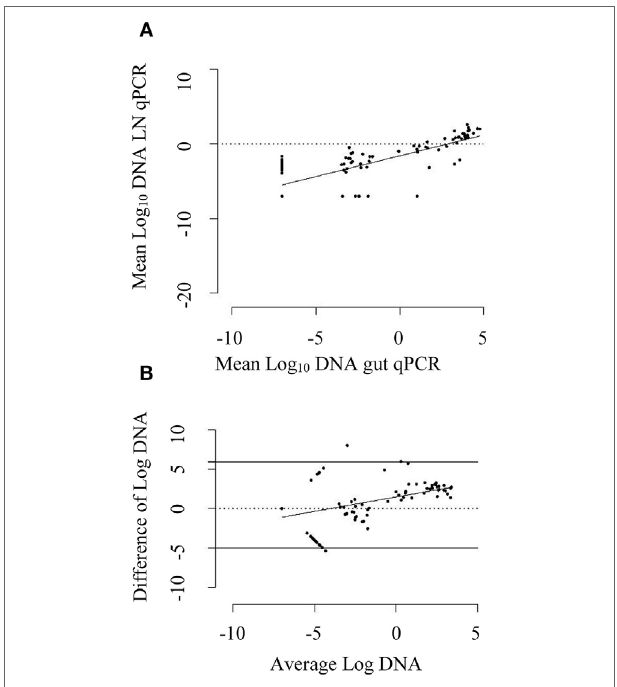
FigUre 3 | (a) Scatter plot of mean log 10 DNA quantified by mesenteric lymph node (MLN) quantitative PCR (qPCR) against log 10 DNA quantified by intestinal tissue (gut) qPCR. The solid line is the regression line. A positive correlation coefficient of 0.78 (95% CI: 0.69, 0.84) was observed. (B) Bland–Altman plot depicting difference of log 10 DNA quantified by gut qPCR and MLN qPCR against average log 10 DNA quantified by them. The dotted line shows the line of perfect agreement whereas two solid lines show the limit of agreement. The DNA quantified by gut qPCR was 2.94 times higher than that quantified by MLN qPCR for the same animal on an average. The solid line is the regression line of average log 10 DNA against difference of log 10 DNA. An increase in average difference was observed for the increase in DNA quantity in the gut and MLN homogenate. TaBle 5 | Comparison of quantitative PCR (qPCR) results (cutoff of ≥ 0.0005 pg/5 µl of DNA extract) of intestinal tissue compared to qPCR results of mesenteric lymph node (MLN)